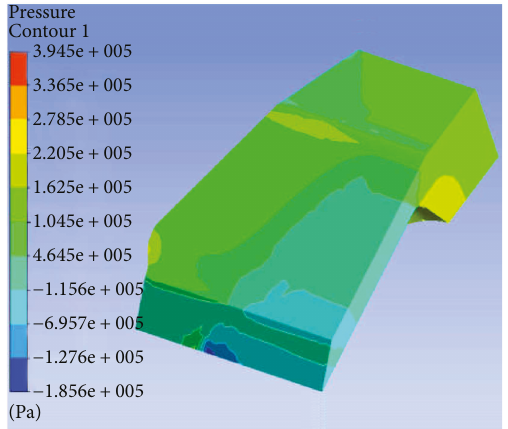
Figure 4: Pressure simulation contour in the head runner.